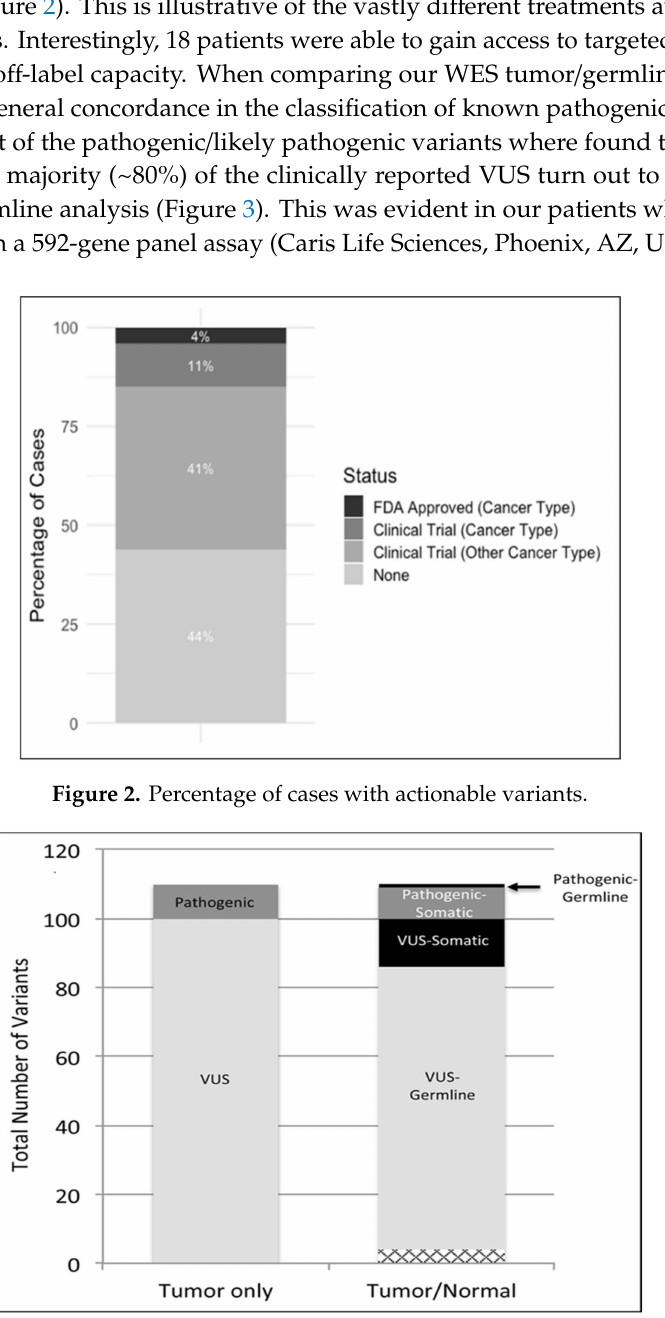
Figure 3. Variants classified as pathogenic or variant of uncertain significance (VUS) in tumor only versus tumor-germline sequence analysis in the seven cases for which both datasets were available (case # 1, 2, 3, 5, 11, 12, and 15 in Table 1). In the latter case, variants could be further classified